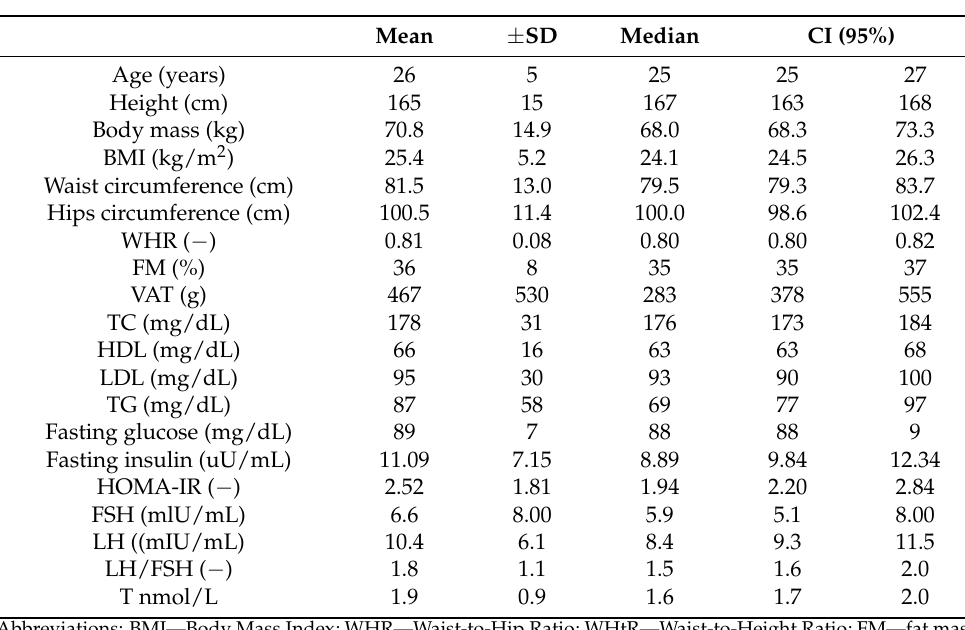
Table 1. Patient’s characteristics ( n = 140).